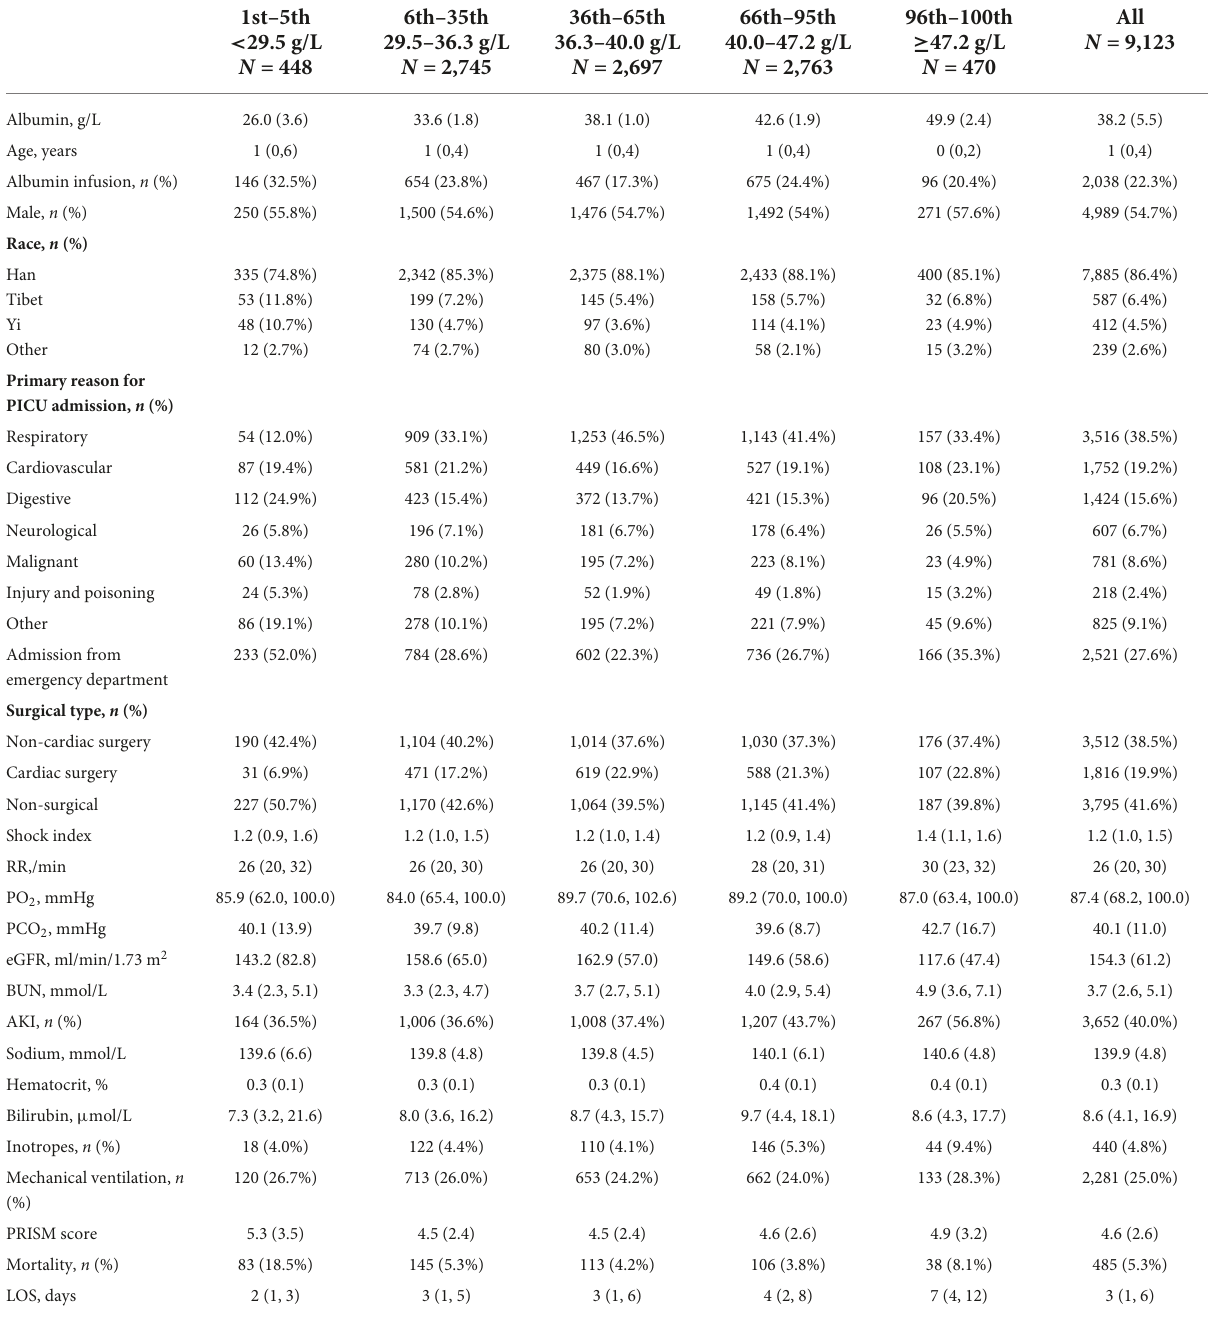
TABLE 1 Baseline characteristics of the